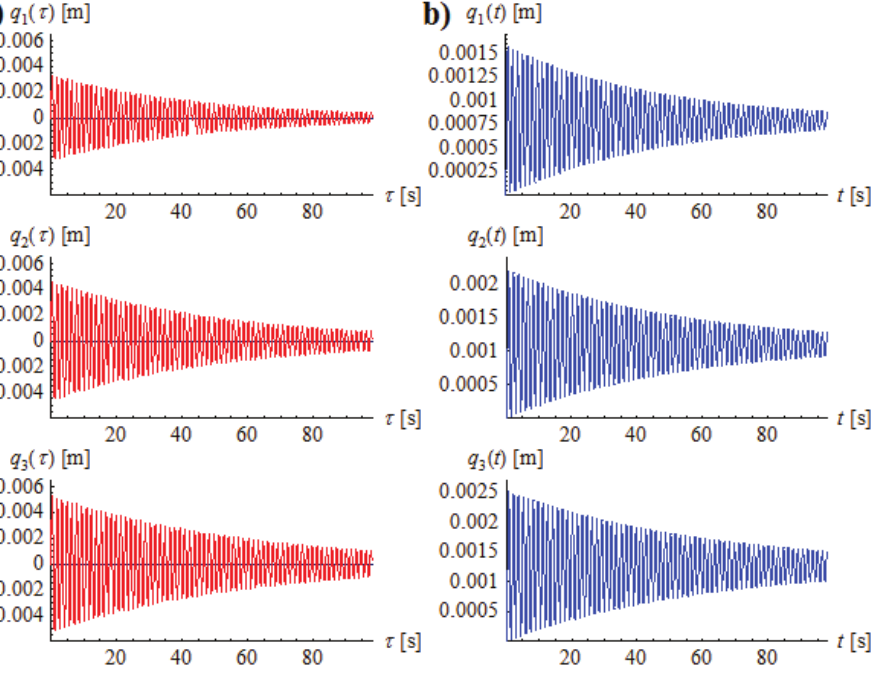
Figure 10: The results obtained from the sixth measurement: (a) displacement plots in the time domain t and (b) displacements determined in accordance with formula (7).